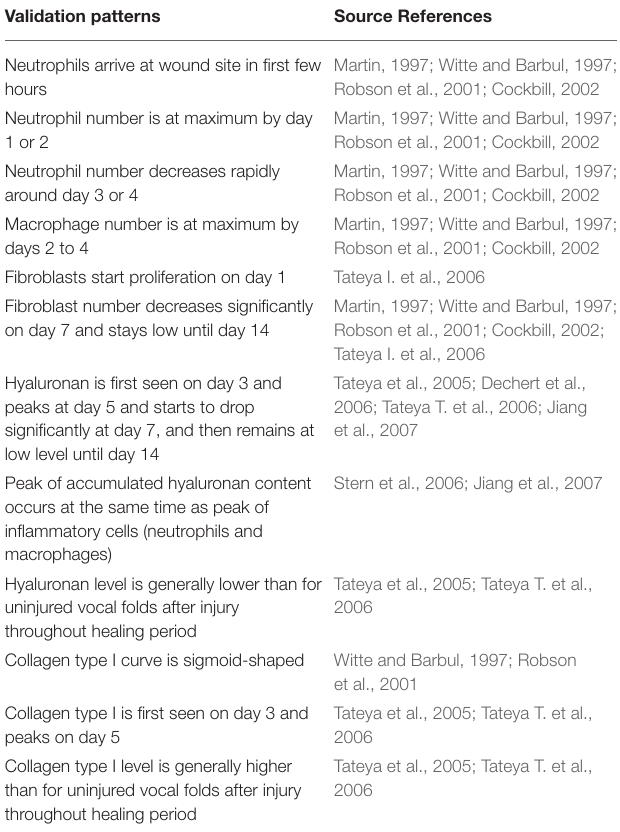
TABLE 6 | Summary of patterns used for qualitatively verify 3D VF-ABM (Li et al., 2010b). Validation